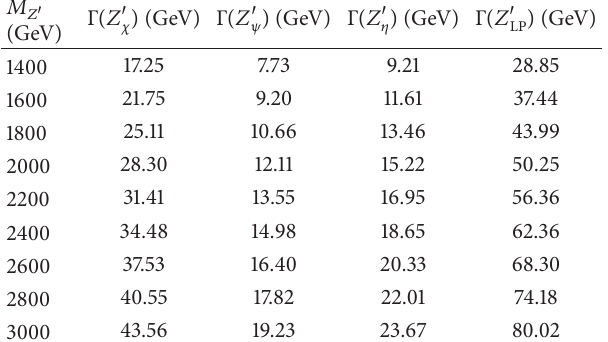
Table 2: The total decay widths of 𝑍 󸀠 boson for different mass values in various models with the FCNC parameter 𝑥 = 0.1 . We use the value of masses of new heavy quarks 𝑚 𝑄 󸀠 = 700 GeV and the masses of new heavy leptons 𝑚 𝑙 󸀠 = 200 GeV and 𝑚 ] 󸀠 = 100 GeV.